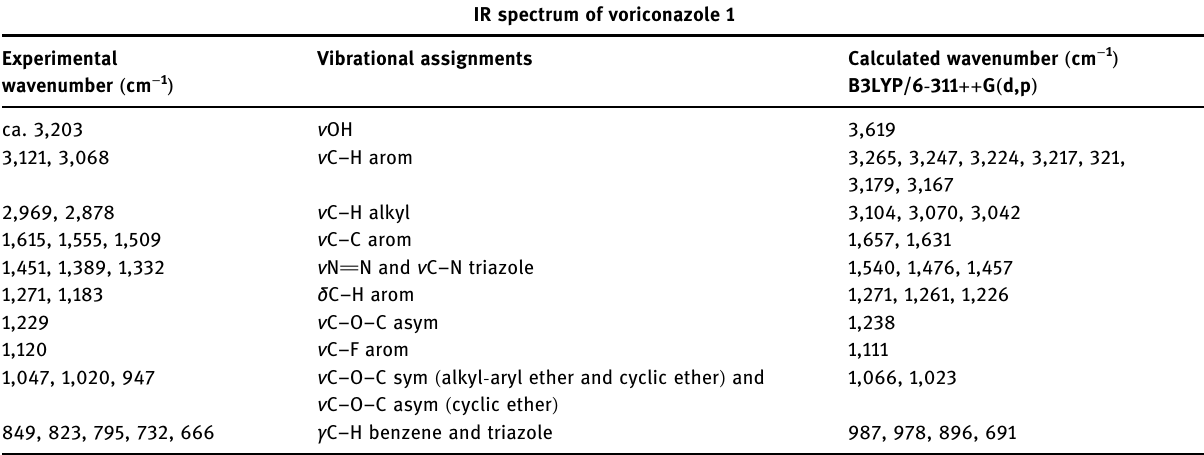
IR spectrum of voriconazole 1